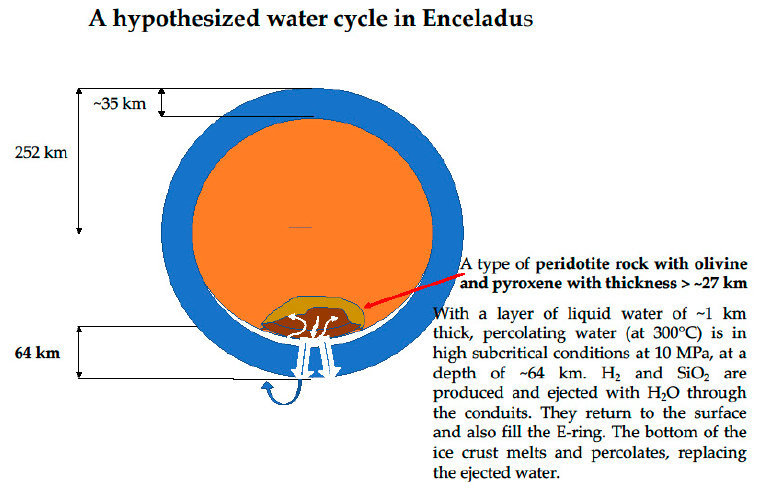
Figure 7. Schematic illustration of a possible water cycle on Enceladus. Water percolates through peridotite rock. With 35 km ice crust and 1 km water, pressure is 10 MPa at a depth of ~28 km inside the core.